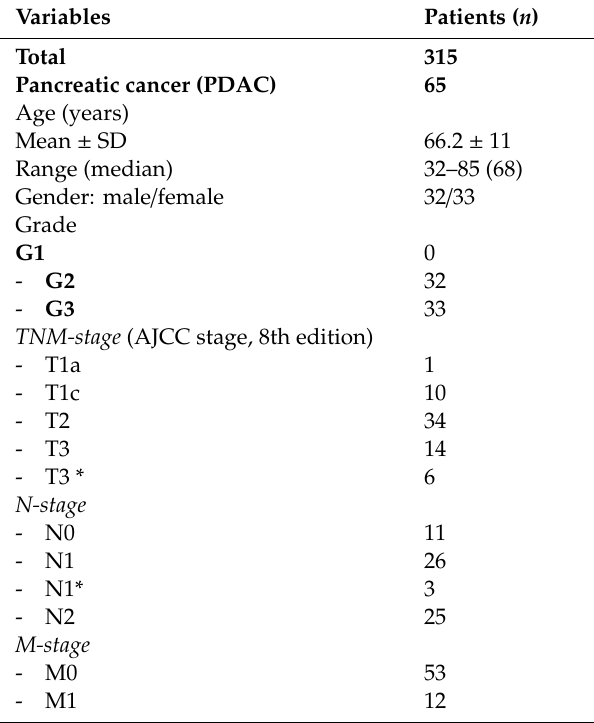
Table 5. Patients’ clinico-pathological